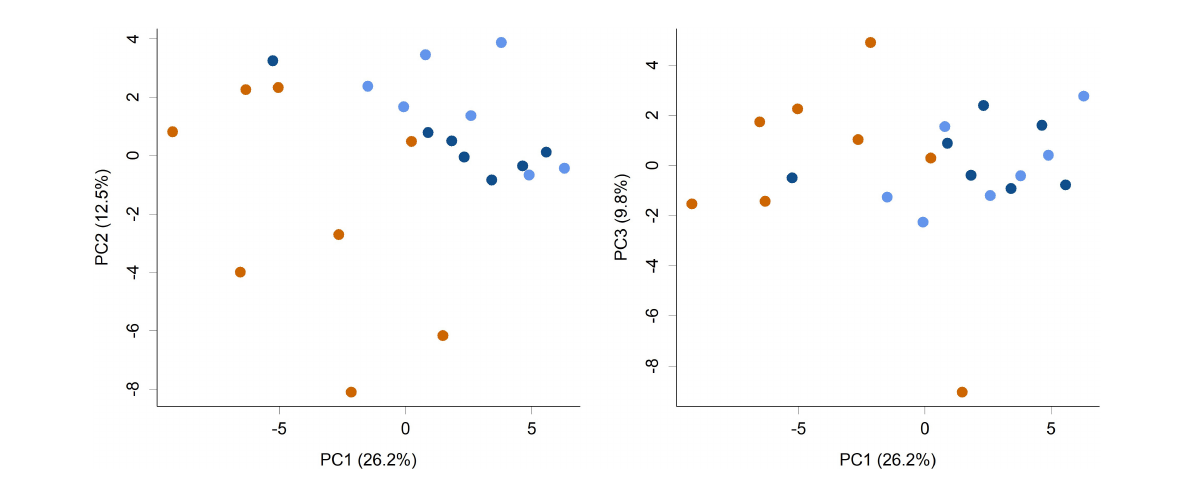
FIGURE2 Principal component analysis (PCA) scores plot of the piglet cecal microbiome community composition at the genus level (PC1 vs. PC2 and PC1 vs. PC3 shown). Colors indicate groups; Control (orange), HN001 Low (light blue), HN001 High (dark blue). Permutation MANOVA P = 0.001 indicates groups had significantly different compositions. Pairwise permutation MANOVAs showed the HN001 Low and HN001 High were not different to each other ( P = 0.283), whereas Controls differed from both HN001 High ( P = 0.012) and HN001 Low ( P = 0.002).